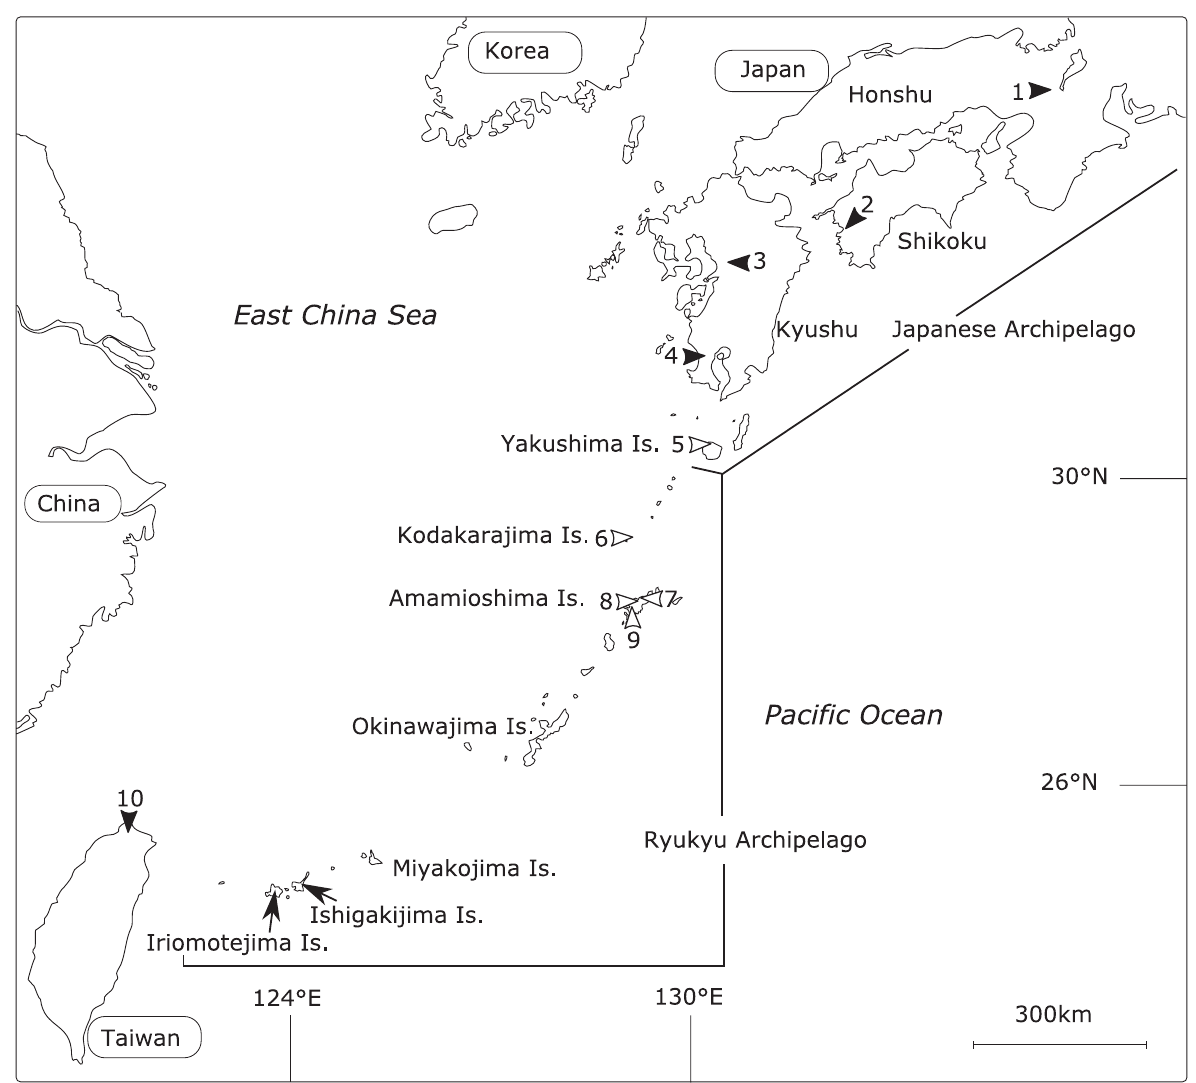
Figure 1. Map showing the known populations of Meteterakis Karve, 1930 inhabiting the Japanese Archipelago, the Ryukyu Archipelago and Taiwan: Meteterakis occidentalis sp. n. (sites 1–4), M. amamiensis Hasegawa, 1990 (sites 5–9; Hasegawa 1990, Sata 2015, 2018), and Meteterakis formosensis sp. n. (site 10). Solid arrows indicate the new species, and open arrows indicate M. amamiensis . Detailed site information can be found in Table